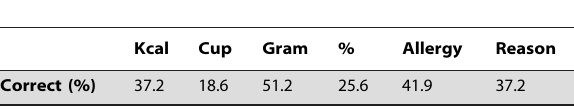
Table 3. Percentage of correct answers for each NVS-J